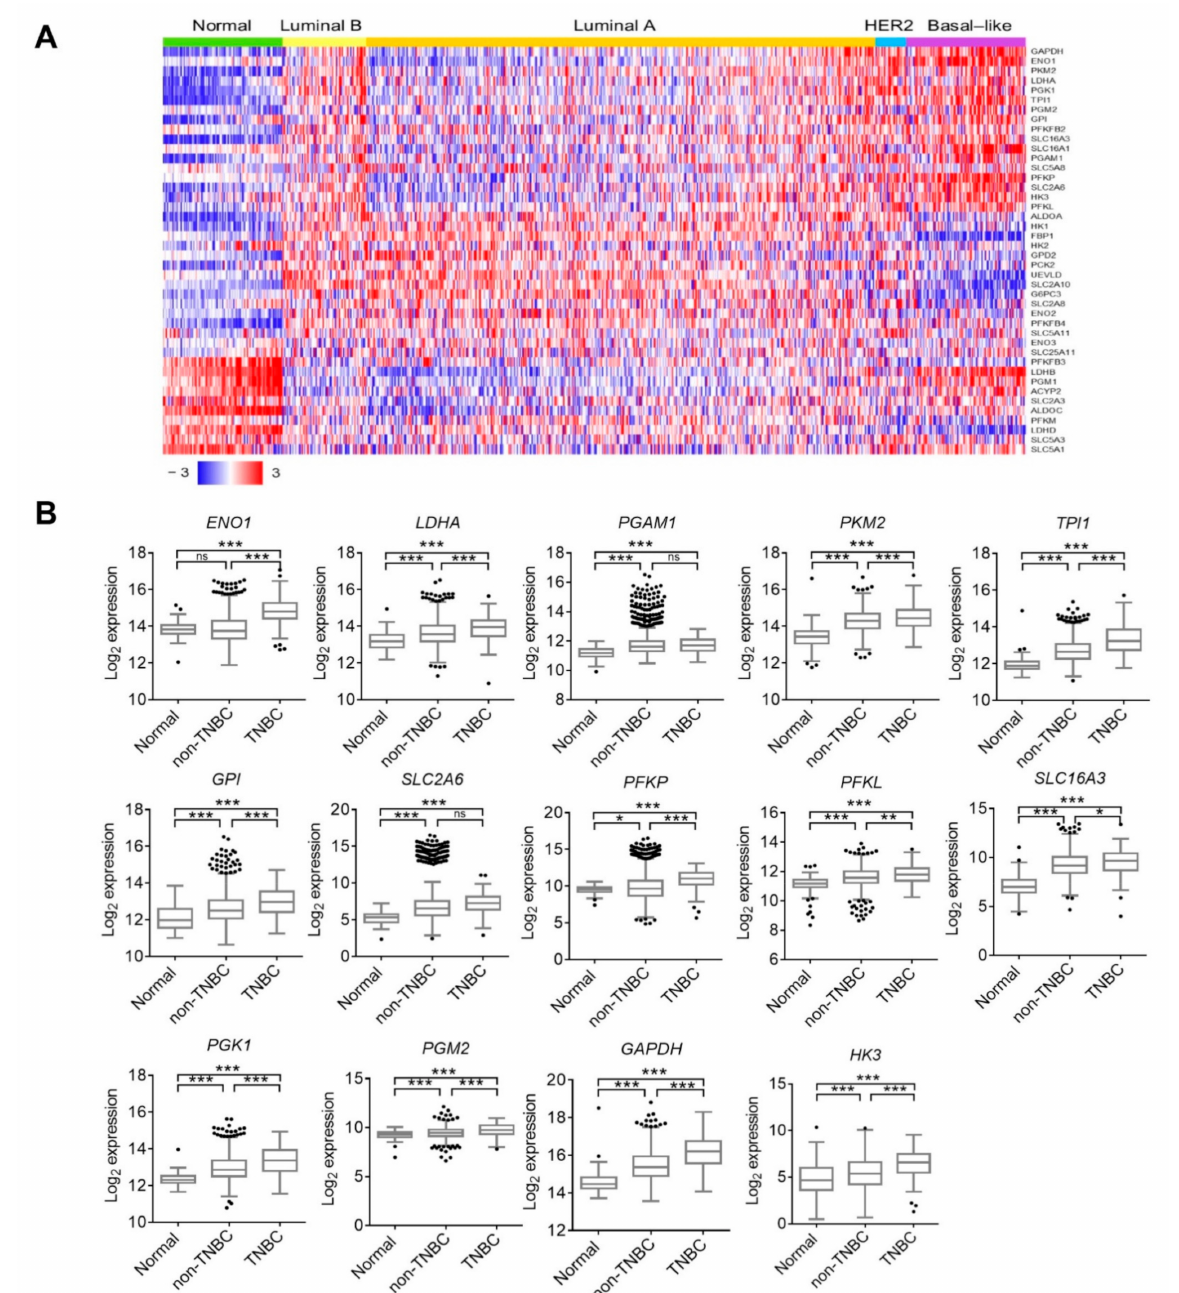
Figure 1. Transcriptome levels of glycolysis-related genes in breast cancer patients. ( A ) Heat map plot of 42 glycolysis-related gene expressions using TCGA_BRCA dataset. Breast cancer patients were characterized by molecular subtypes, including luminal A ( n = 499), luminal B ( n = 197), human epidermal receptor 2 (HER2) ( n = 78), and basal-like triple-negative breast cancer (TNBC) ( n = 171), and normal adjacent tissues ( n = 36). ( B ) Box plots with Tukey whiskers of 14 glycolysis-related gene expressions in TCGA_BRCA cohort. Subjects were characterized as normal ( n = 36), basal-like TNBC ( n = 171), and non-TNBC ( n = 774). * p < 0.05, ** p < 0.01, and *** p < 0.001 as determined by an ANOVA. ns, not